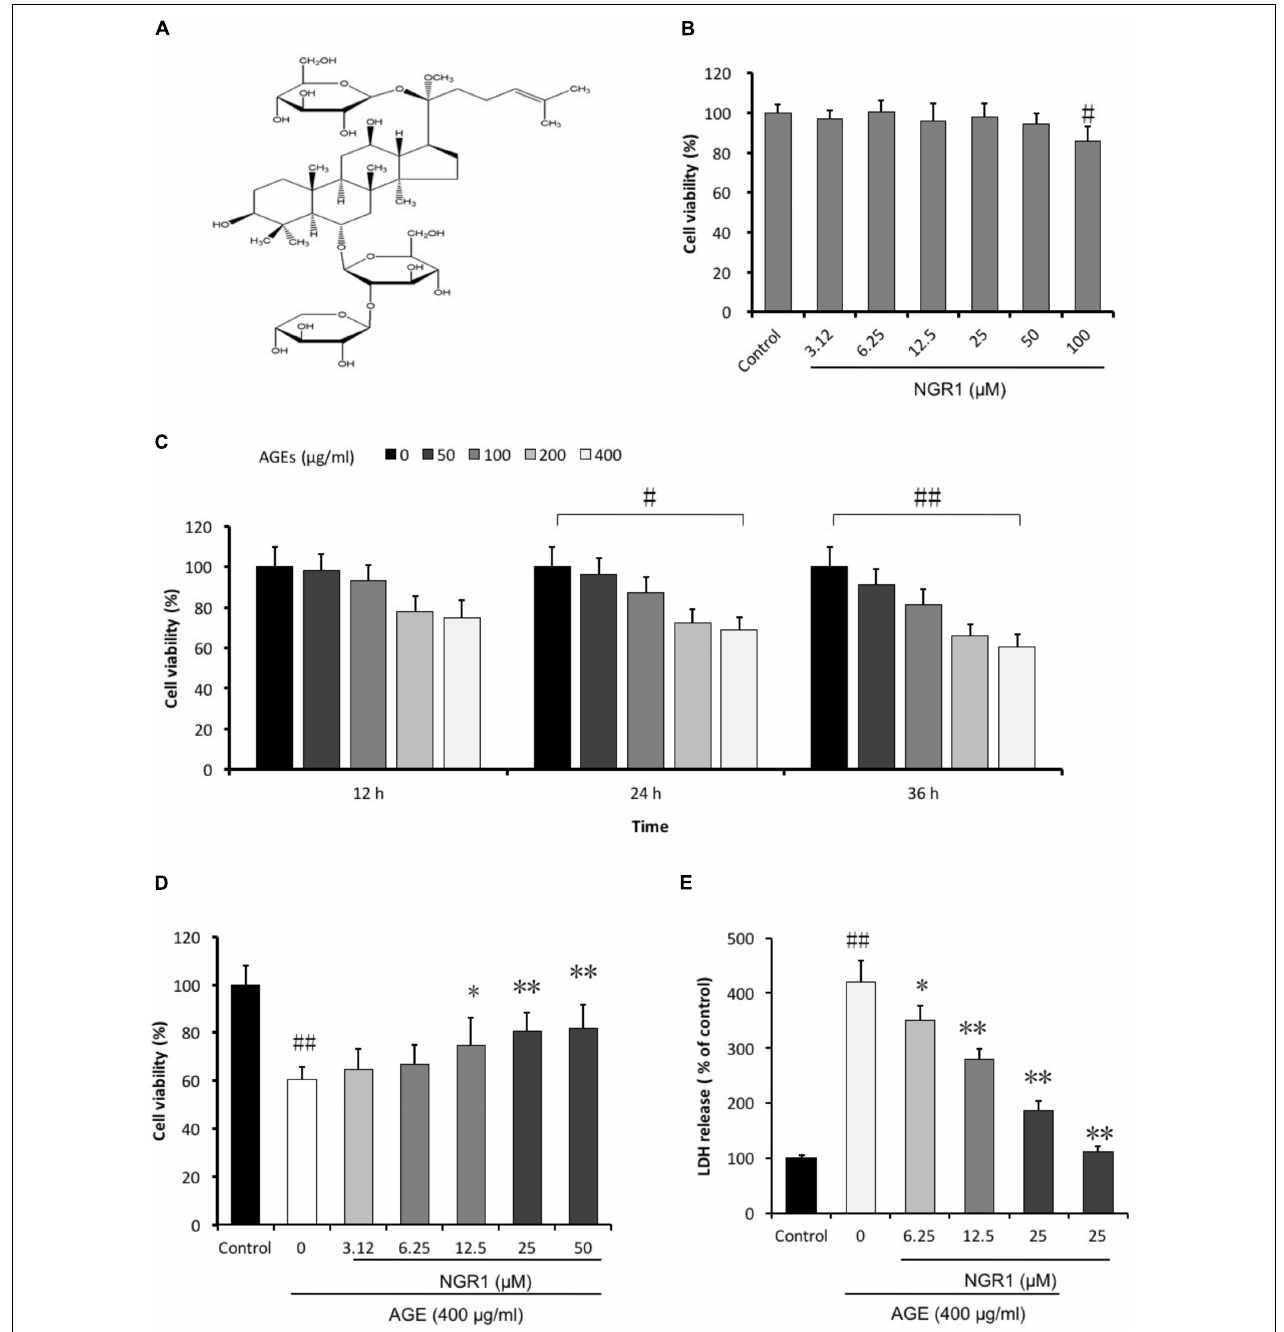
FIGURE 1 | NGR1 protects against H9c2 cell death induced by AGEs. (A) Molecular structure of NGR1. (B) Toxic effect of NGR1 on H9c2 cell viability was insignificant up to 50 µ M. (C) H9c2 cell viability was affected by the incubation of AGEs for 36 h. (D) NGR1 attenuated H9c2 cell death induced by AGEs. (E) NGR1 decreased H9c2 cell LDH release induced by AGEs. The quantitative data are presented as the mean ± SD of three independent experiments. # P < 0.05 or ## P < 0.01 vs. the Control group, ∗ P < 0.05 or ∗∗ P < 0.01 vs. the AGEs